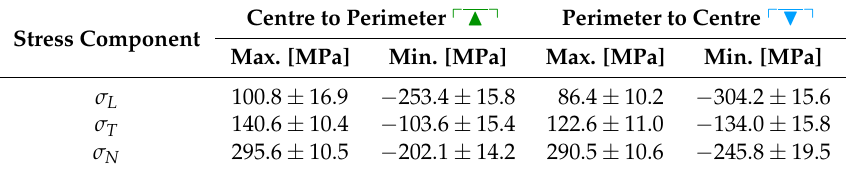
Table 2. Max. and min. values of the orthogonal stress components in the